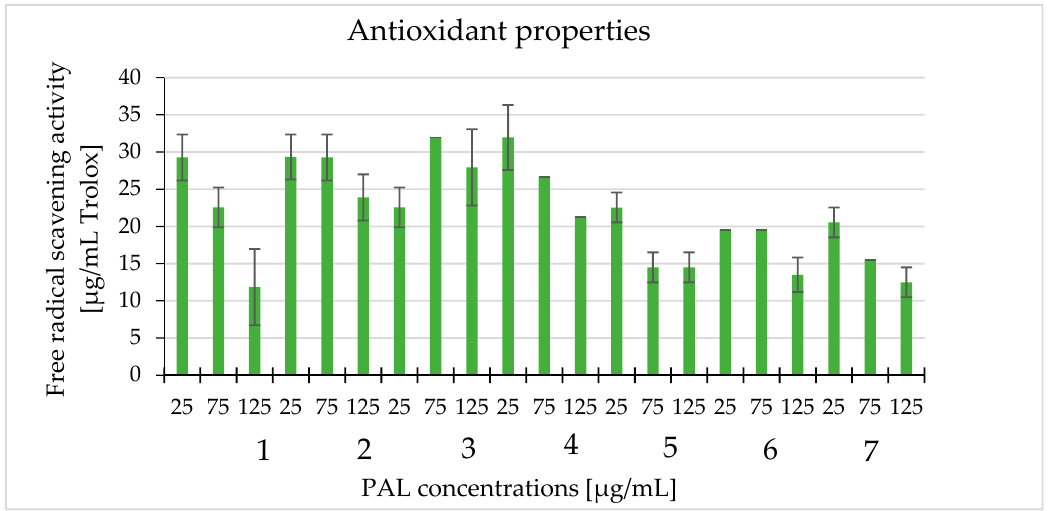
Figure 5. The antioxidant properties of the tested extracts (PAL1–PAL7) at the concentrations 25, 75, and 125 μ g/mL with the 2,2-diphenyl-1-picrylhydrazyl (DPPH) radical scavenging method and expressed as Trolox equivalents ( μ g/mL).